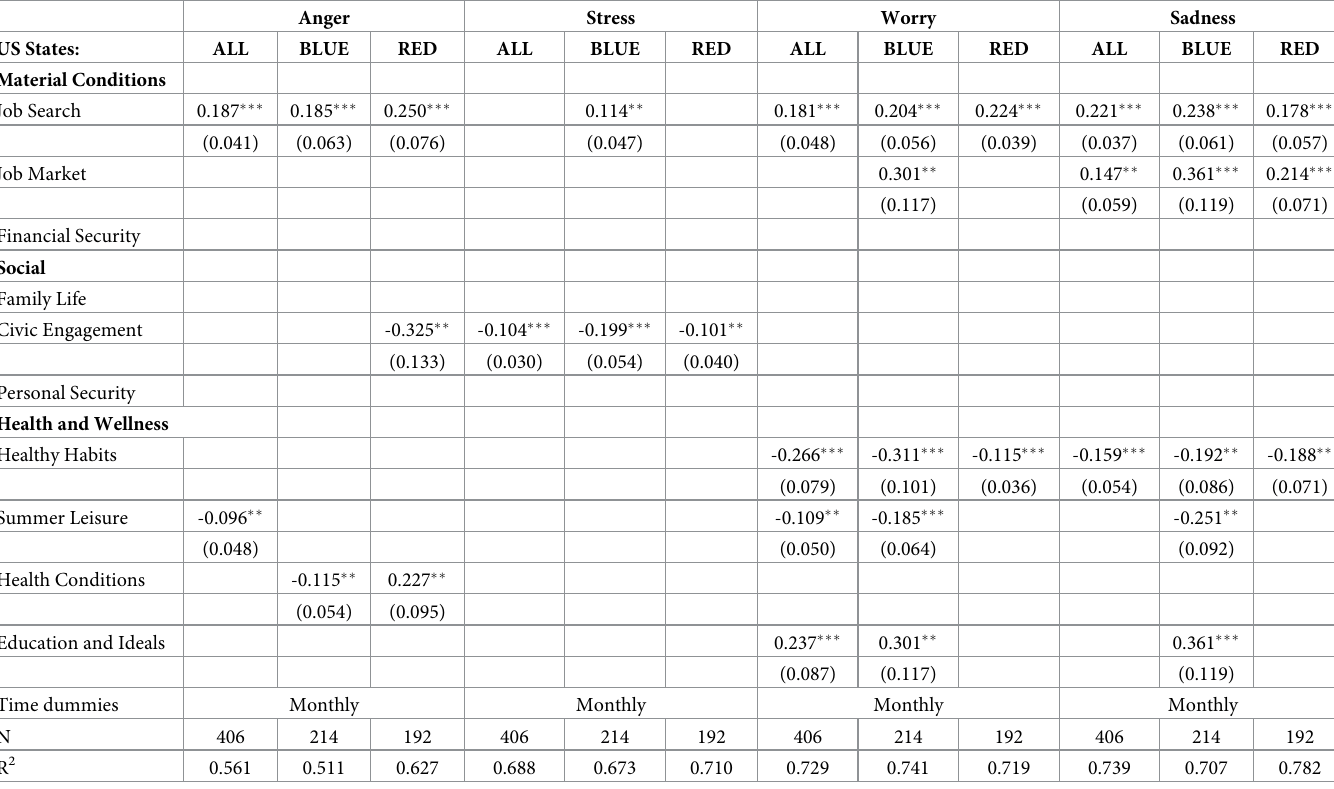
Table 4. Regression of categories on subjective well-being data–negative affects (state level).